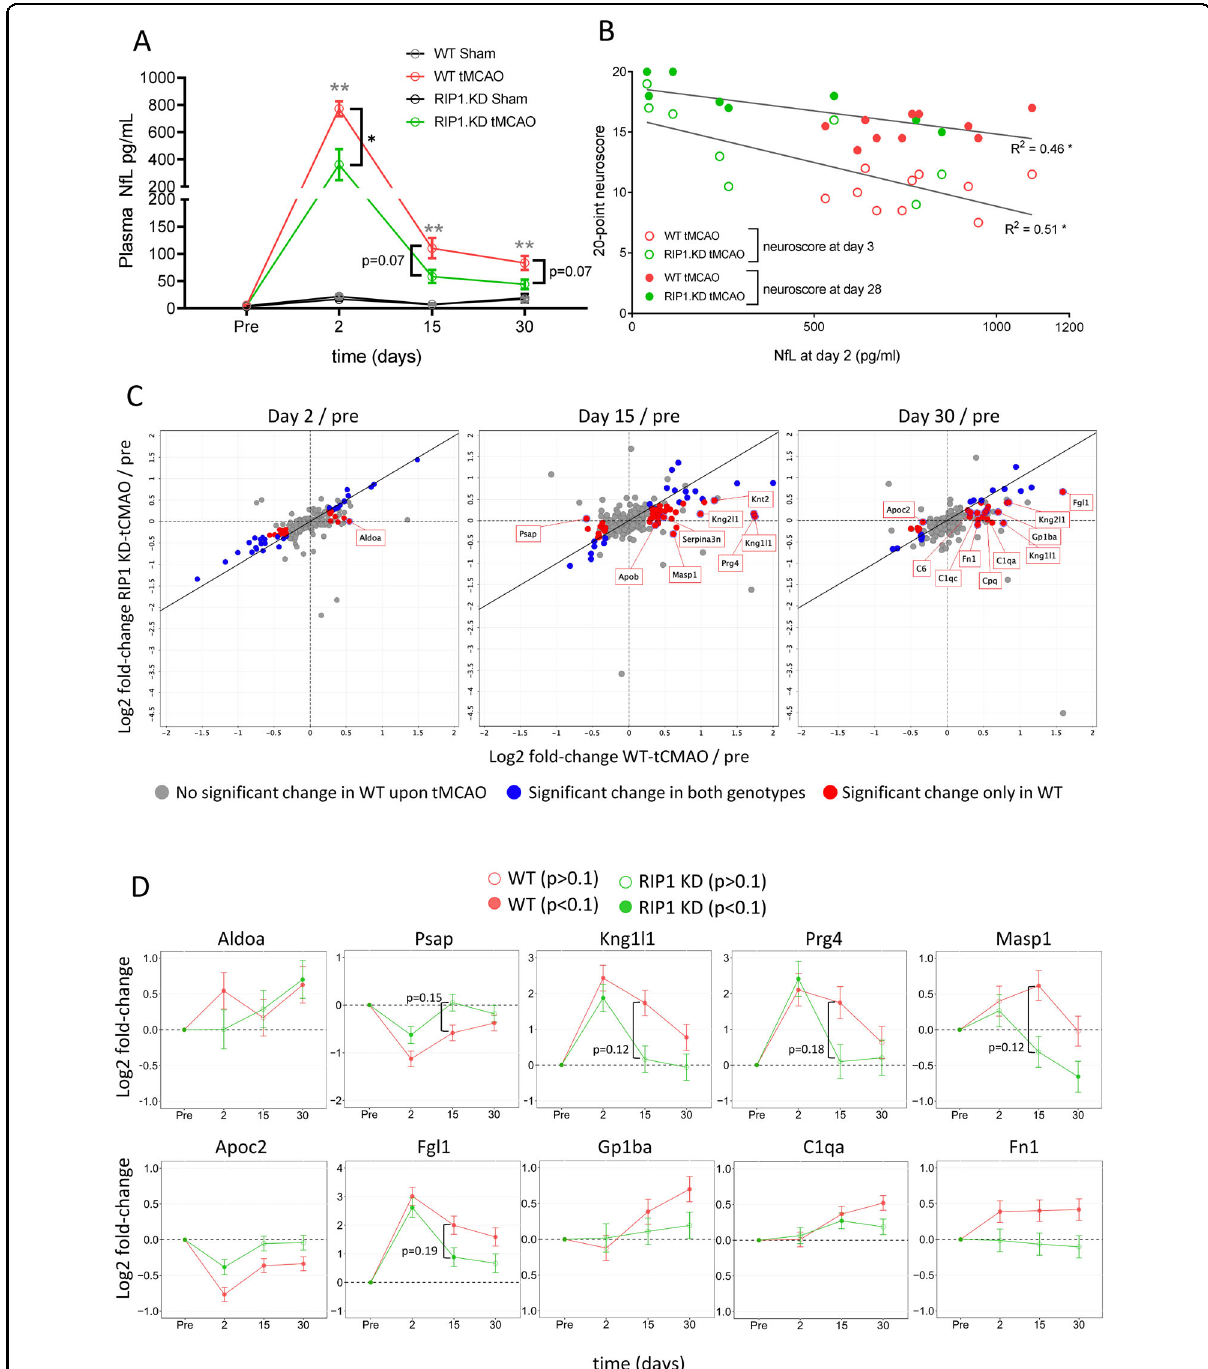
Fig. 5 (See legend on next